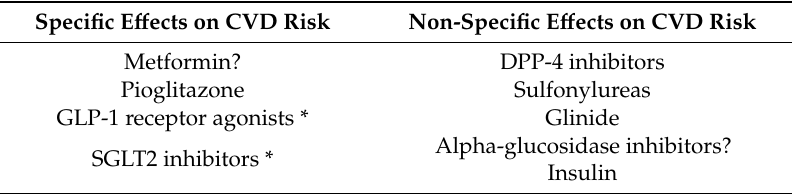
Table 2. E ff ects on CVD risk among glucose-lowering